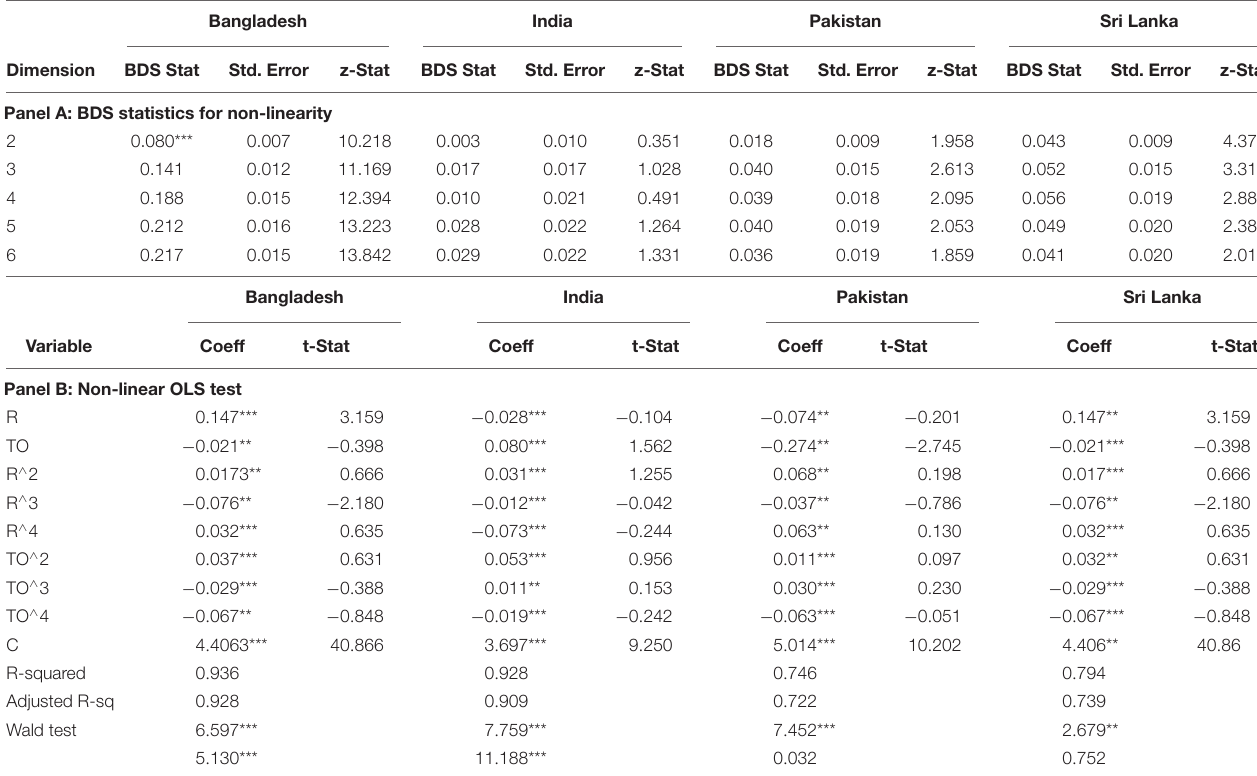
TABLE 5 | Results of Brock–Dechert–Scheinkma (BDS) and